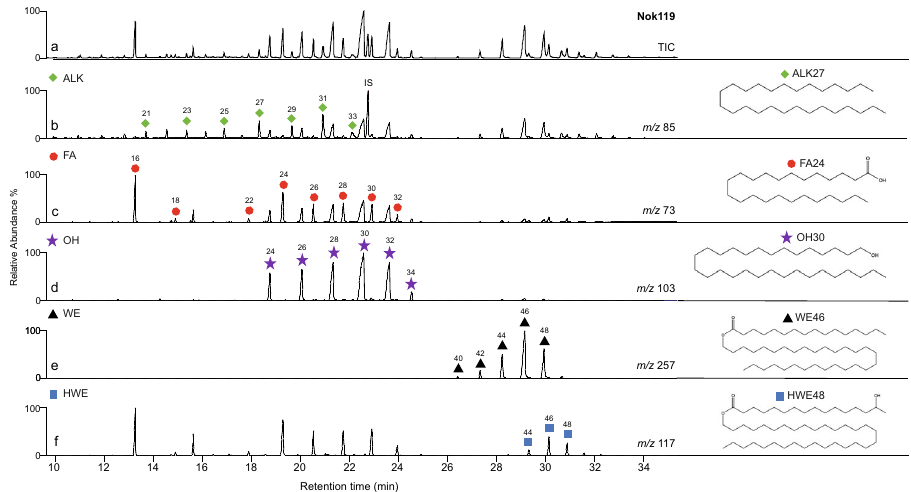
Fig. 5 High-temperature gas chromatography/mass spectrometry chromatograms of a total lipid extract, containing beeswax, from potsherd NOK119. a . partial total ion current chromatogram and b - f . mass chromatograms displaying ion masses of characteristic fragments from the main compound classes comprising the extract ( m/z 85, 73, 103, 257 and 117, respectively), showing one of the molecular structures of each compound class. Green rhombus, n -alkanes (ALK); red circles, n -alkanoic acids (fatty acids, FA); purple stars, n -alkanols (OH); black triangles, fatty acyl monoesters (WE); blue squares, hydroxyl fatty acyl monoesters (HWE); IS, internal standard ( n- tetratriacontane). Numbers denote carbon chain